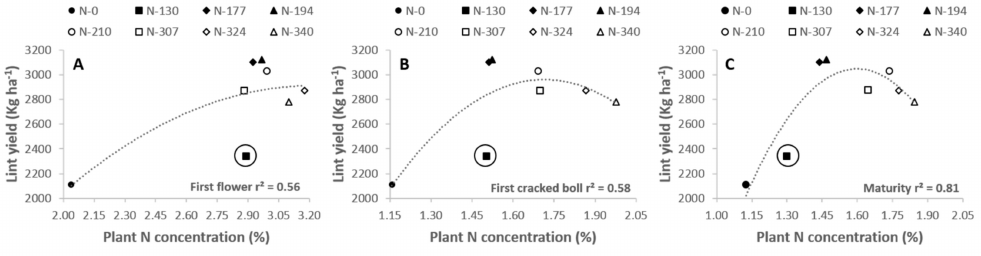
Figure 9. Relationships between lint yield and plant N concentration at first flower ( A ), first cracked boll ( B ) and maturity ( C ). The treatment that received all nitrogen on 10 December 2015 by top dressing with Urea, N-130, is highlighted with a